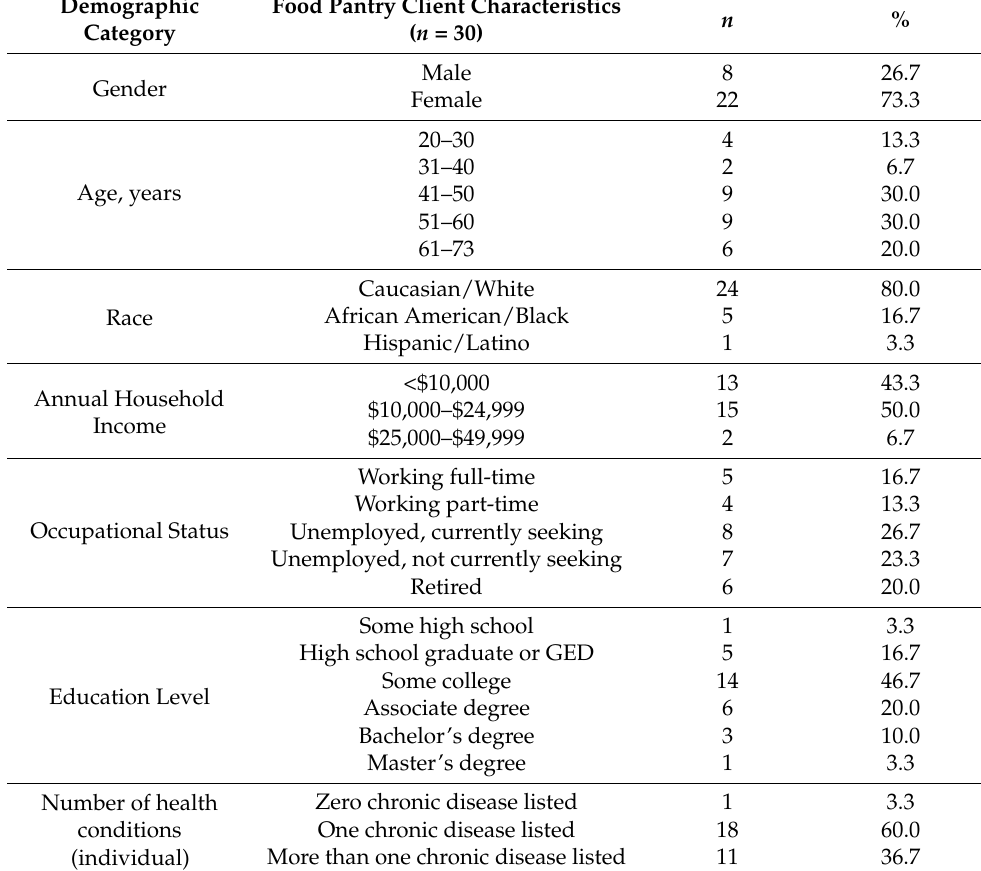
Table 1. Pantry client demographic Characteristics and health